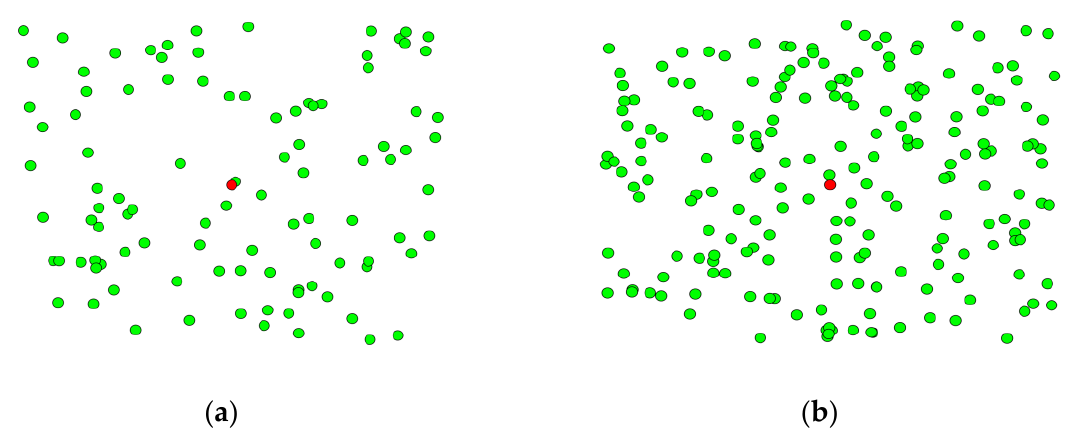
Figure 3. Simulation outcomes using BEA ‐ SSA model for node counts of ( a ) 100 and ( b ) 200.